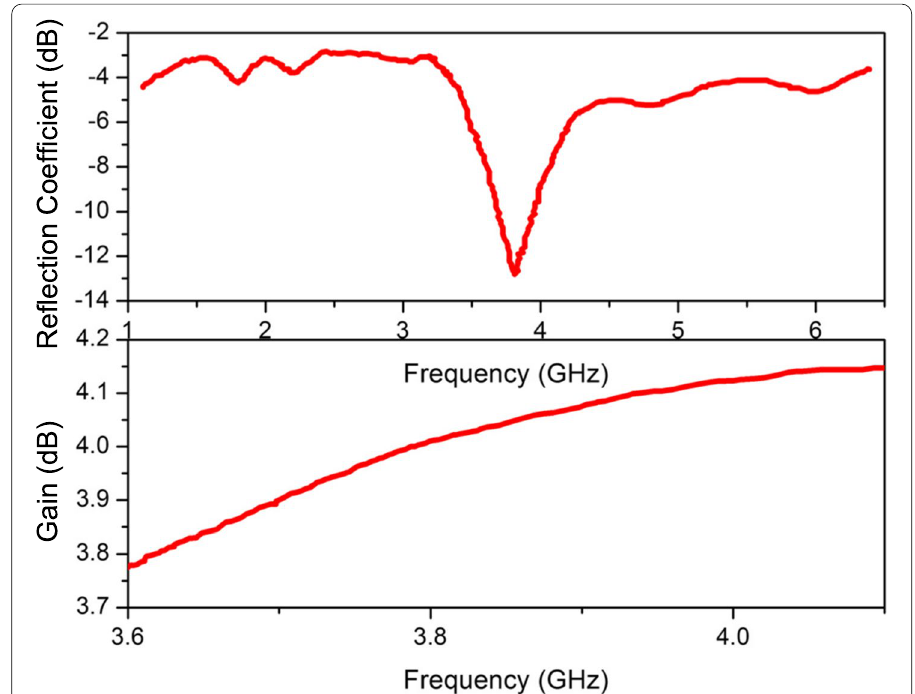
Fig. 12 Reflection coefficient and gain of three layers of SRR metamaterial-embedded antenna